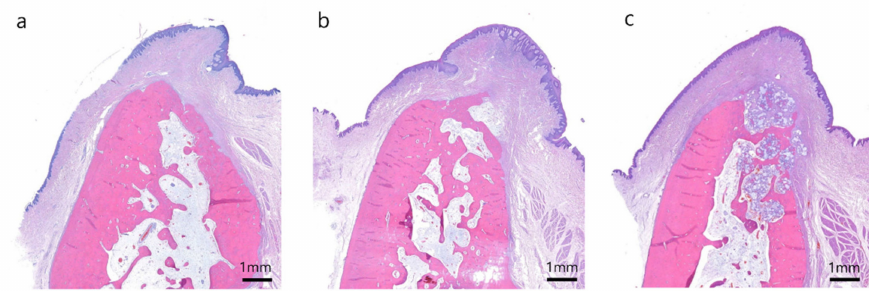
Figure 6. Buccolingual section on hematoxylin and eosin staining at 12 weeks after extraction in the ( a ) control group, ( b ) T1 group and ( c ) T2 group.